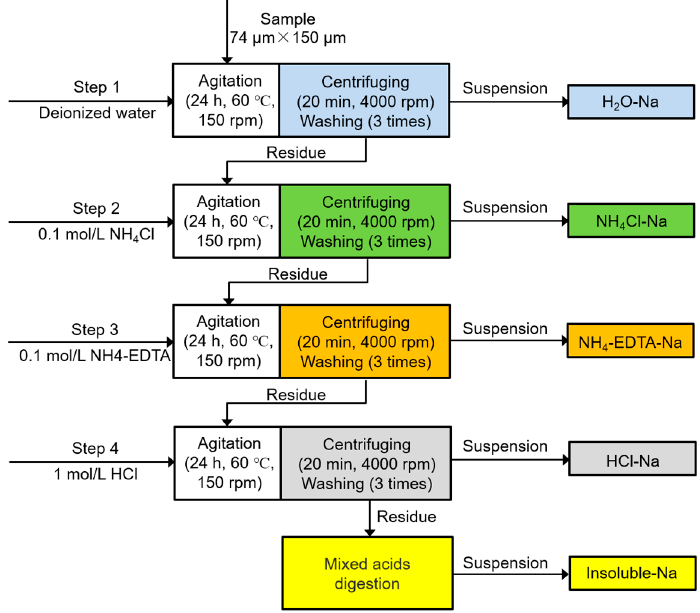
Figure 2. Diagram of sequential chemical extraction procedure.